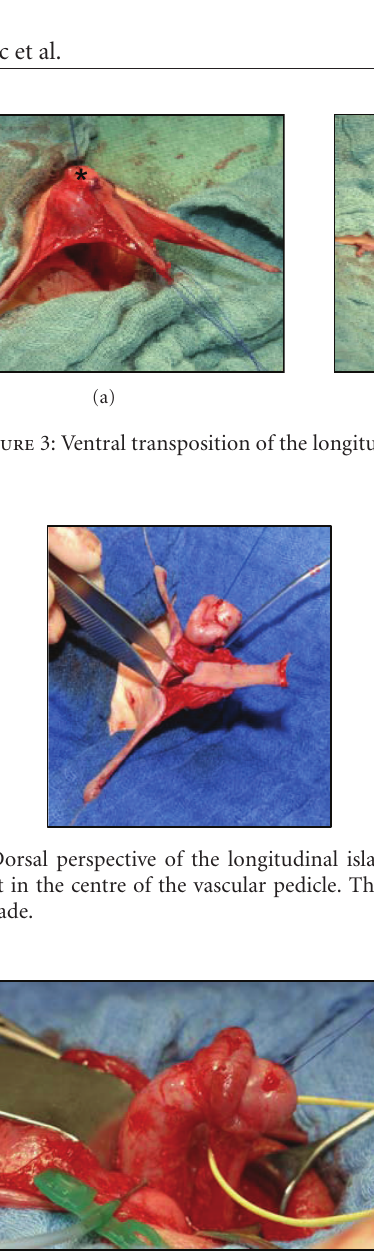
Figure 5: After complete mobilisation of the urethra and artificial erection of the penis, the ventral curvature with a short urethral plate becomes evident.